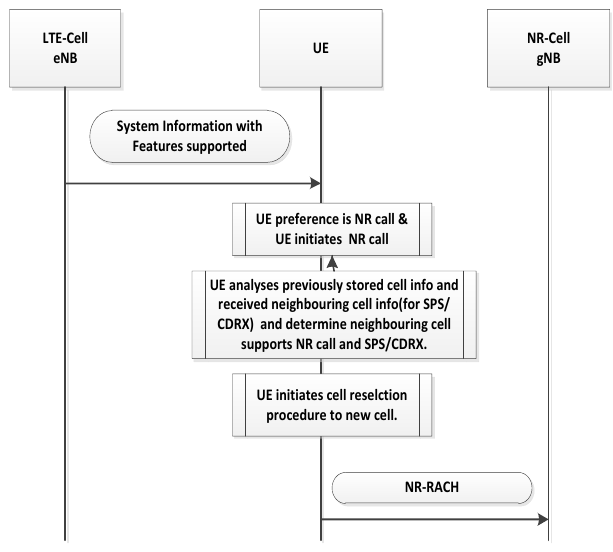
Fig. 8. Extended Approach for